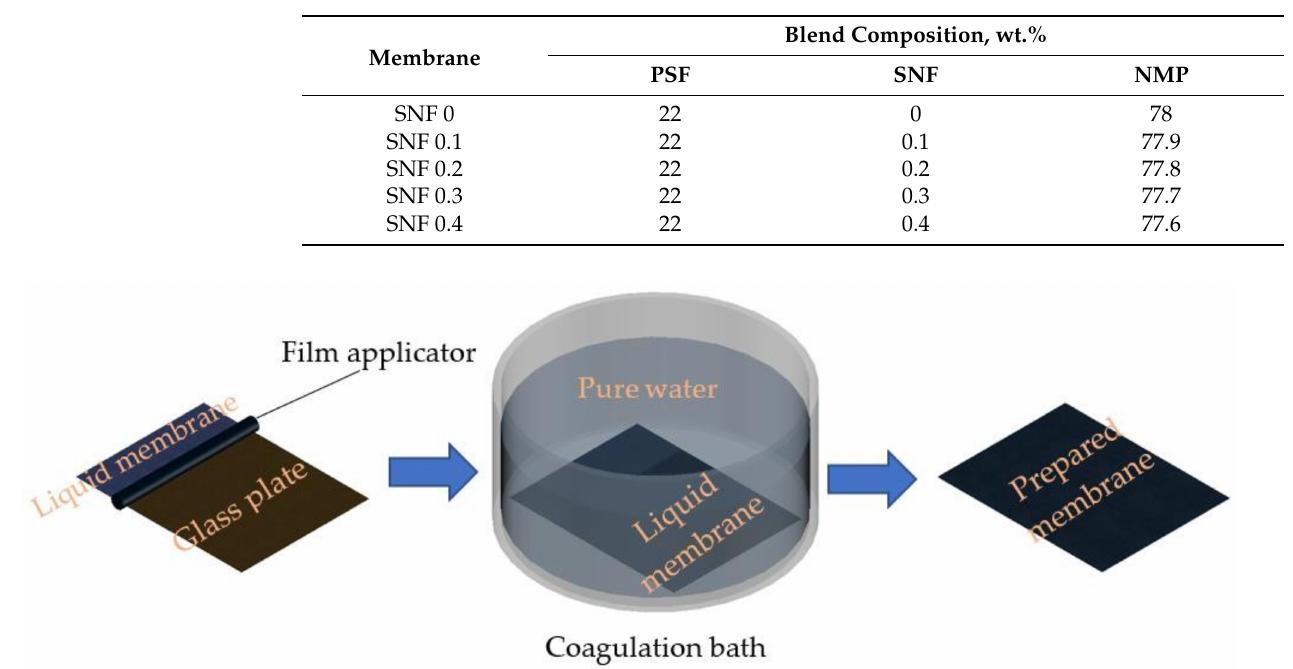
Table 1. Composition of the casting solution of PSF/SNF membranes.